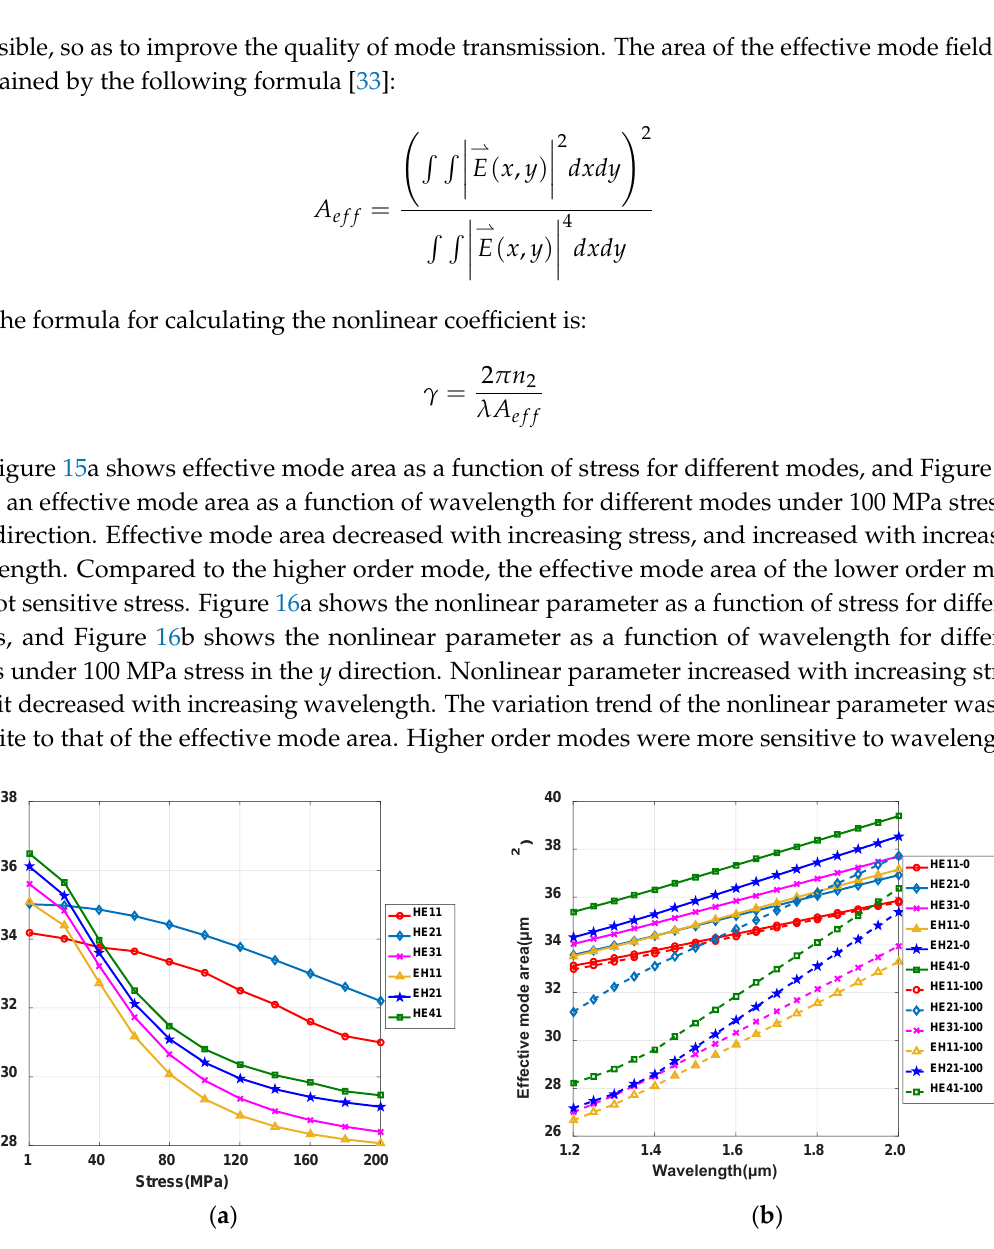
Figure 15. ( a ) Effective mode area as a function of stress for different modes, and ( b ) effective mode area as a function of wavelength for different modes under 100 MPa stress in the y direction.